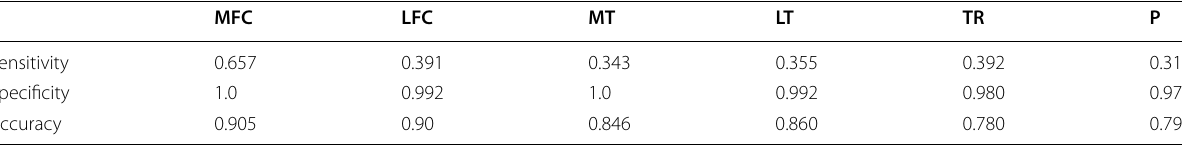
MFC Medial femoral condyle